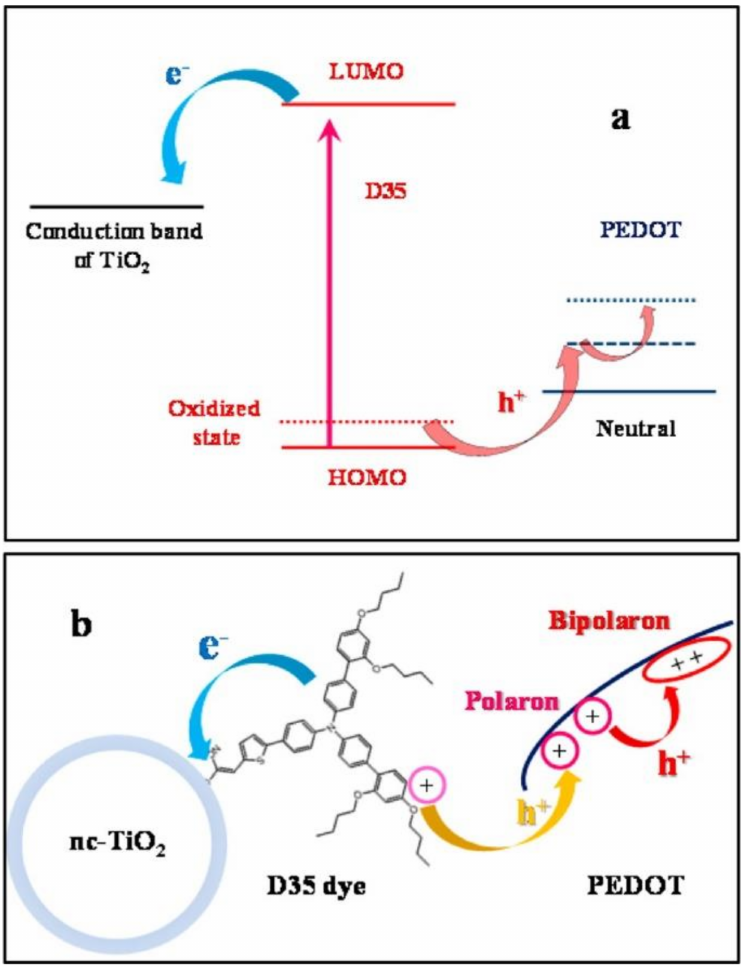
Figure 11. Use of PEDOT as hole transporting layer in ss-DSSCs: ( a ) energy level diagrams and ( b ) charge separation pathways relevant to ss-DSSC functioning. Reprinted with permission from [82]. Copyright 2013 American Chemical